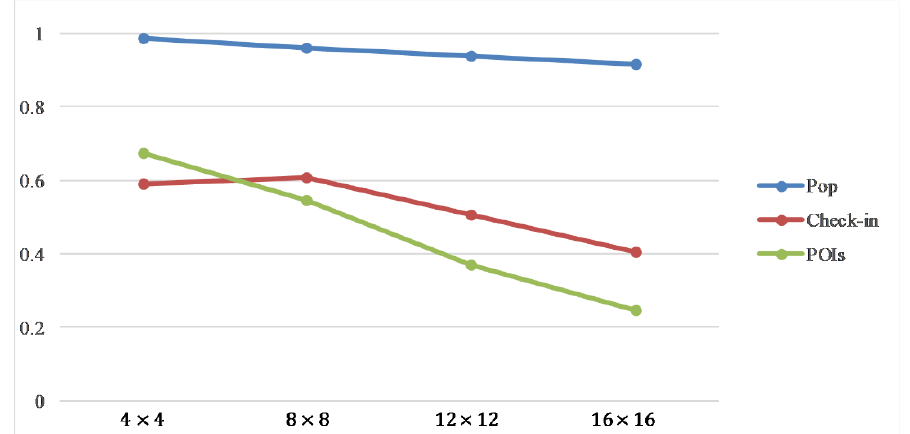
Figure 9. Results of the feature spatial correlation coefficient.